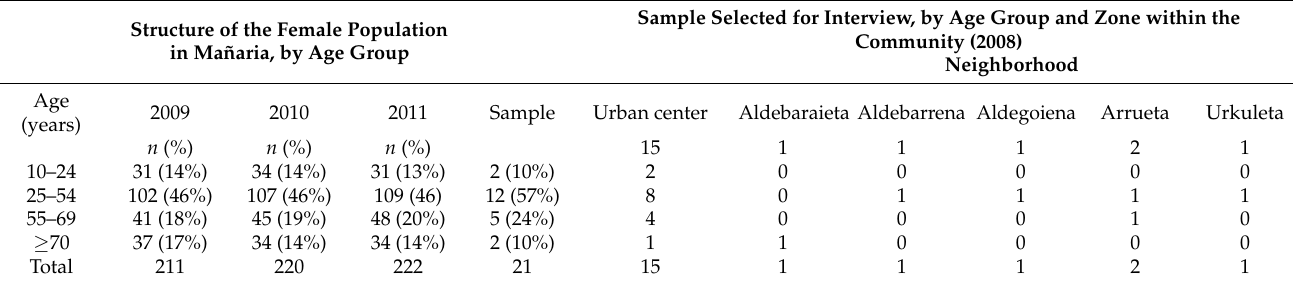
Table 1. Structure of the female population in Mañaria and sample population. Sample Selected for Interview, by Age Group and Zone within the Structure of the Female Population Community (2008) in Mañaria, by Age Group Neighborhood Sample Urban center Aldebaraieta Aldebarrena Aldegoiena Arrueta